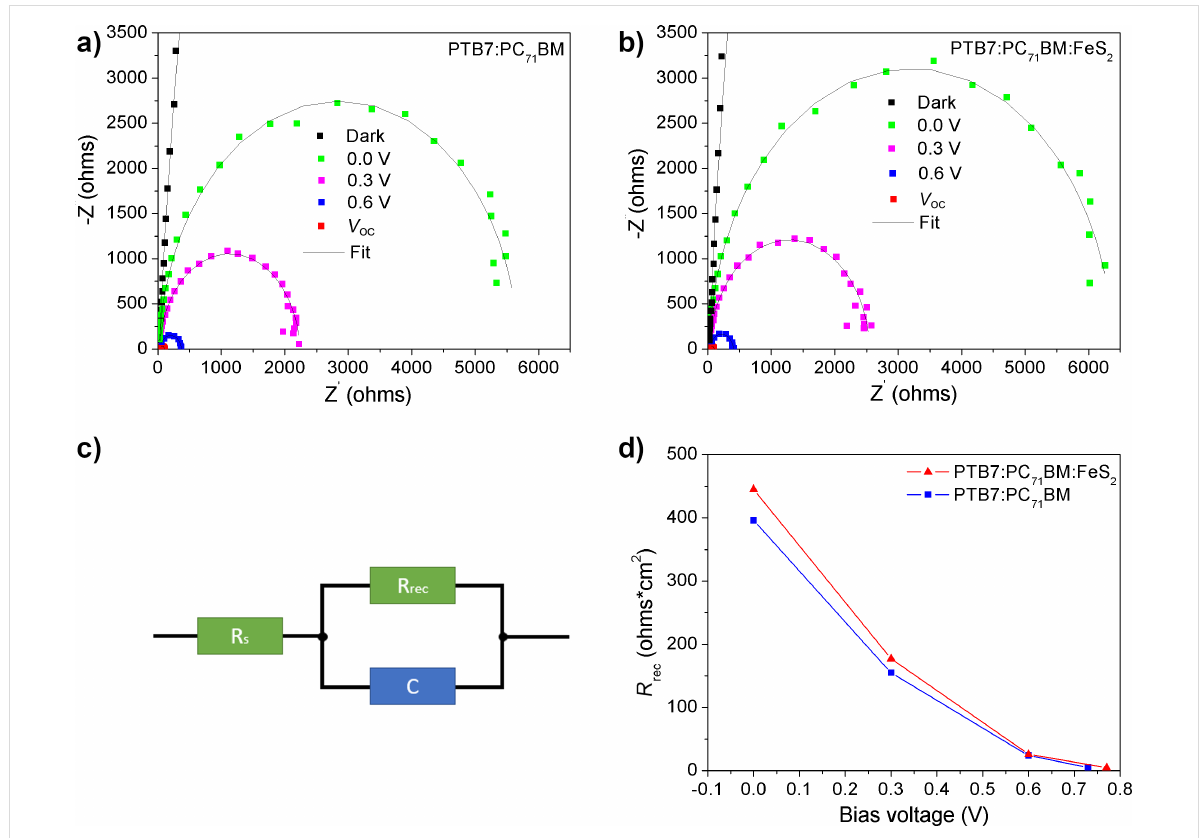
Figure 8: Impedance spectroscopy measurements (filled color squares) and simulations (black lines) of a) PTB7:PC 71 BM and b) PTB7:PC 71 BM:FeS 2 with 0.5 wt % of FeS 2 ; c) equivalent circuit used for the IS simulations; d) R rec values vs bias voltage of PTB7:PC 71 BM (blue) and PTB7:PC 71 BM:FeS 2 (with 0.5 wt % of FeS 2 ) (red).